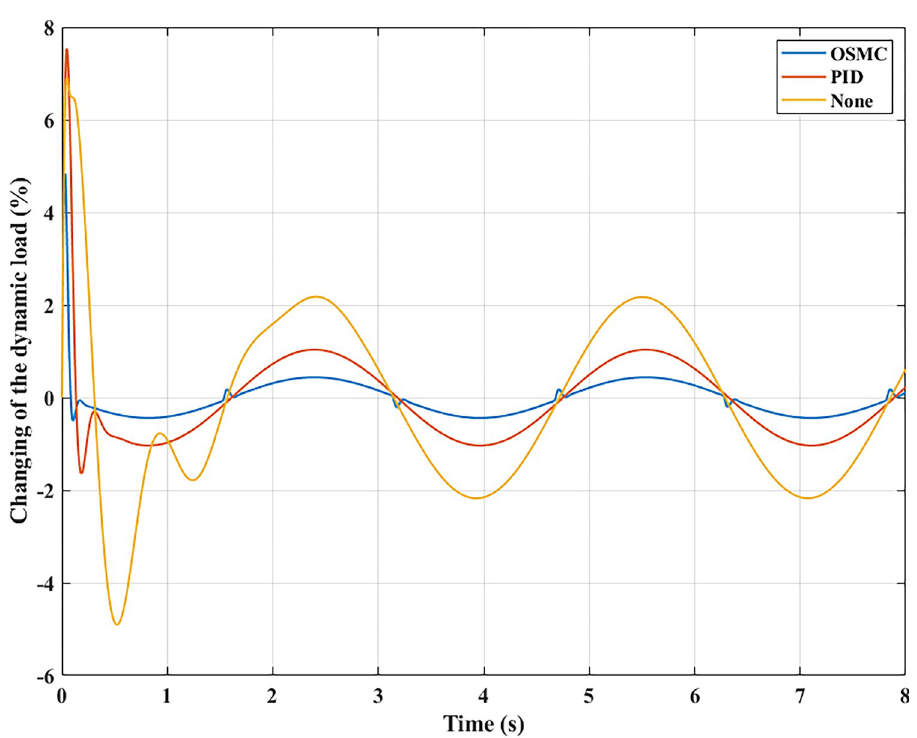
Fig 17. Changing the dynamic load (case 1).